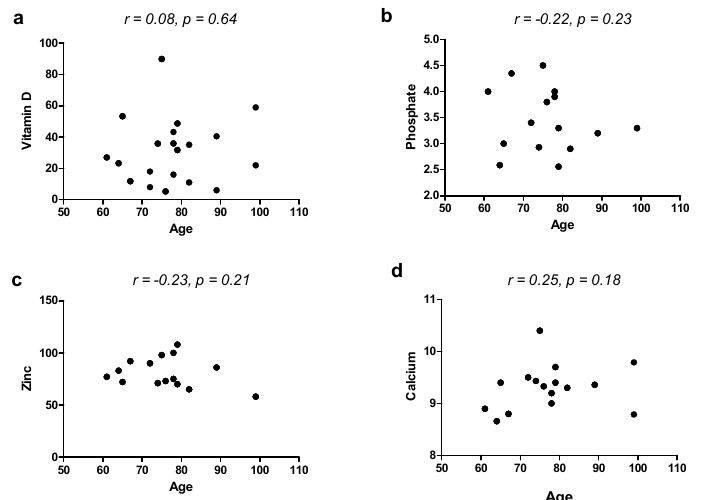
Figure 1. Correlation between age and blood levels of vitamin D ( a ), phosphate ( b ), zinc ( c ) and calcium ( d ).